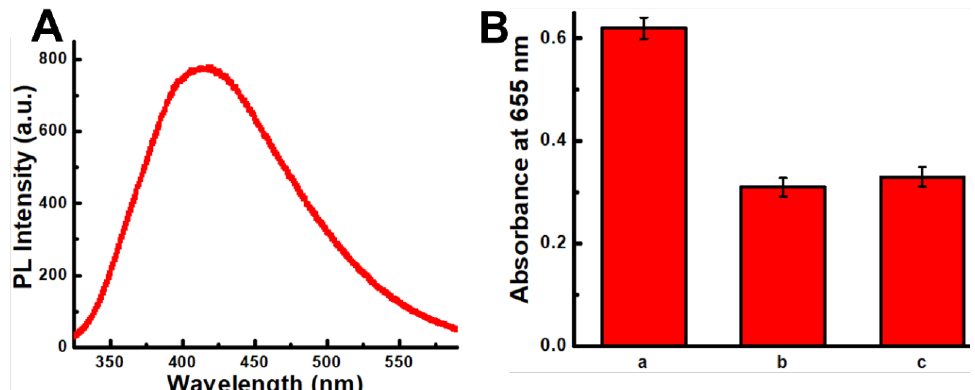
Figure 6. ( A ) Fluorescence emission of 2-Hydroxy-1,4-benzenedicarboxylic acid. ( B ) The absorbance intensity of SCN − -Au QDs in the presence of H 2 O 2 and TMB (a); after adding citric acid (b) and ascorbic acid on sample a, separately (c).